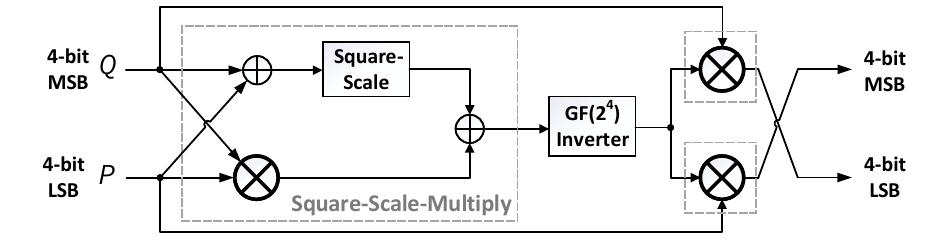
Figure 4: Inversion in GF (2 4 ) 2